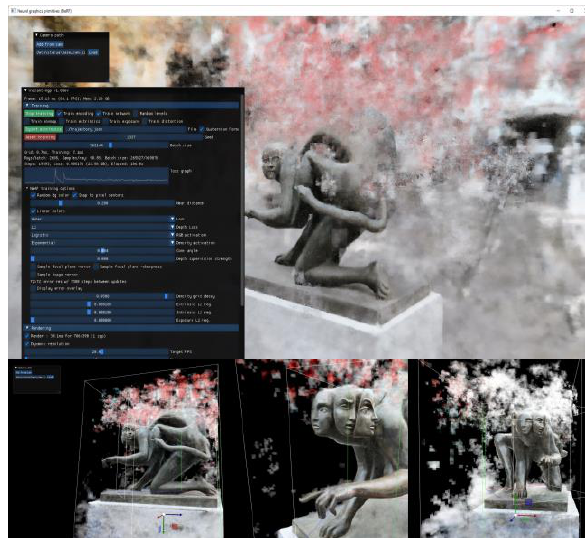
Figure 5 . first experiments whit Ai calculi for the survey of the Gonzalez statue.